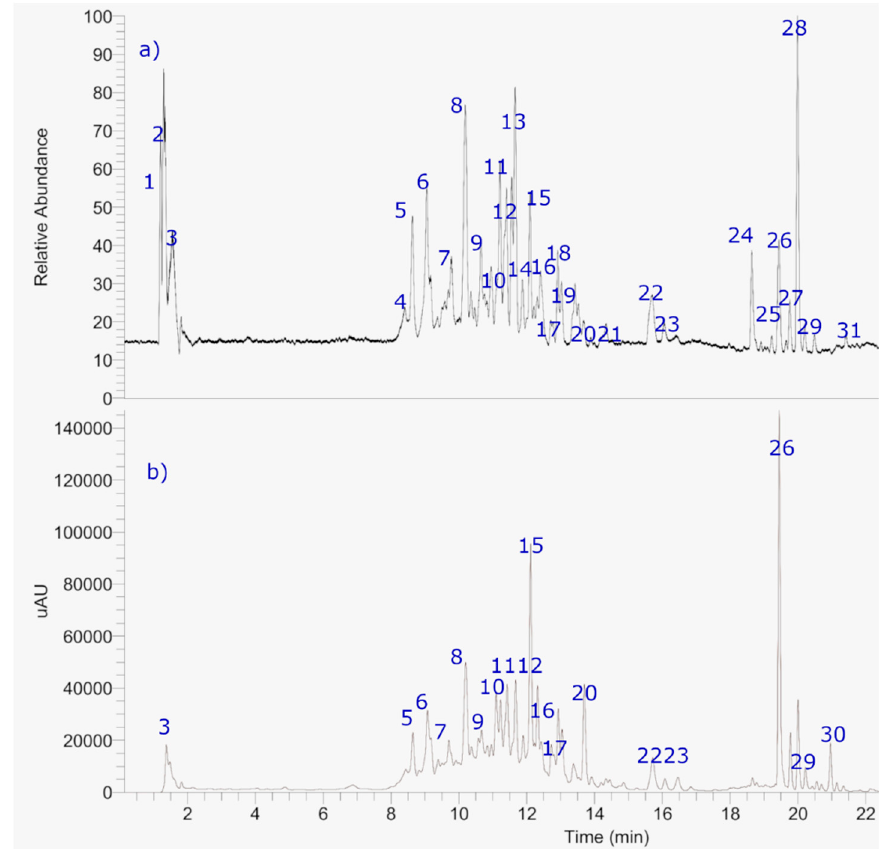
Figure 3. The HPLC-MS Fingerprints of Baccharis grisebachii lyophilized decoction: ( a ) The total Ion Current (TIC) chromatogram and ( b ) the UV-vis chromatogram at 280 nm.